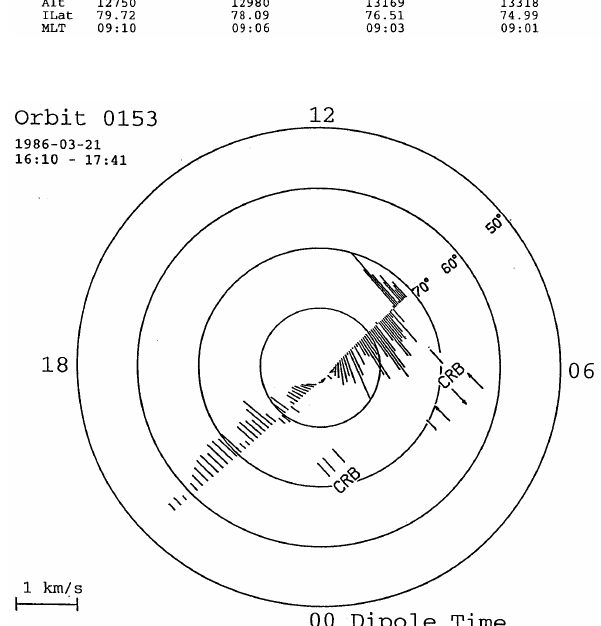
Fig. 13. The same as Fig. 7b, except for 21 March 1986, 1715–1740 UT.